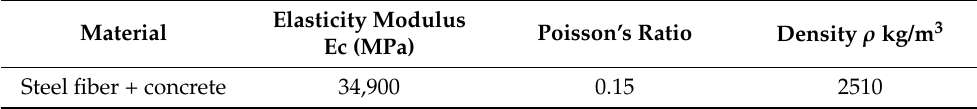
Table 4. Strength parameters of steel fiber-reinforced concrete lining.